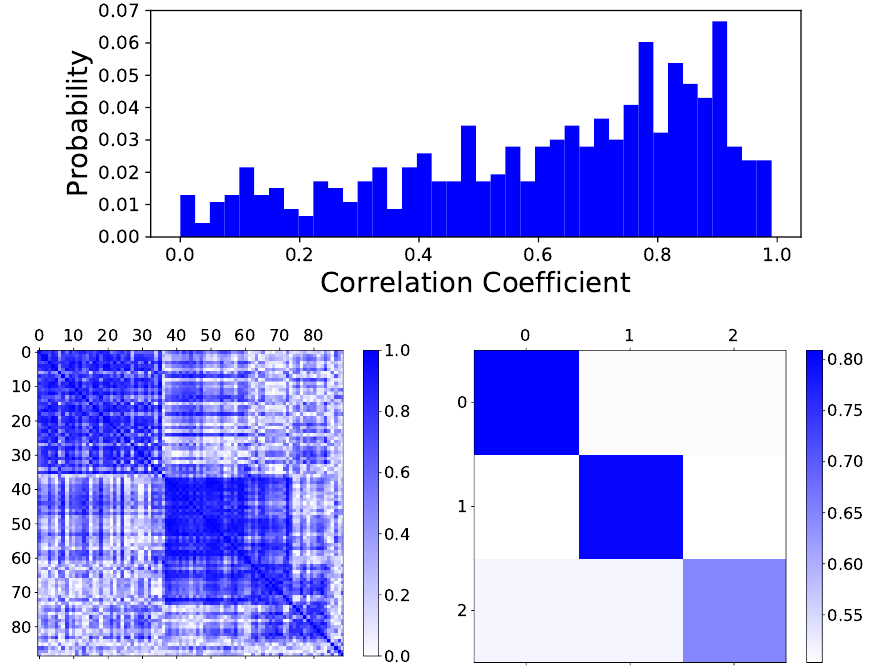
Figure 2. Identification of correlation patterns in temperature data. ( Top ) Histogram of the absolute correlation between all pairs of daily temperature profiles. ( Bottom left ) Correlation matrix between all pairs of daily temperature profiles (i.e., the nodes of the network). Please note that nodes (days) are sorted in order to highlight the community structure. ( Bottom right ) Average correlation within and between